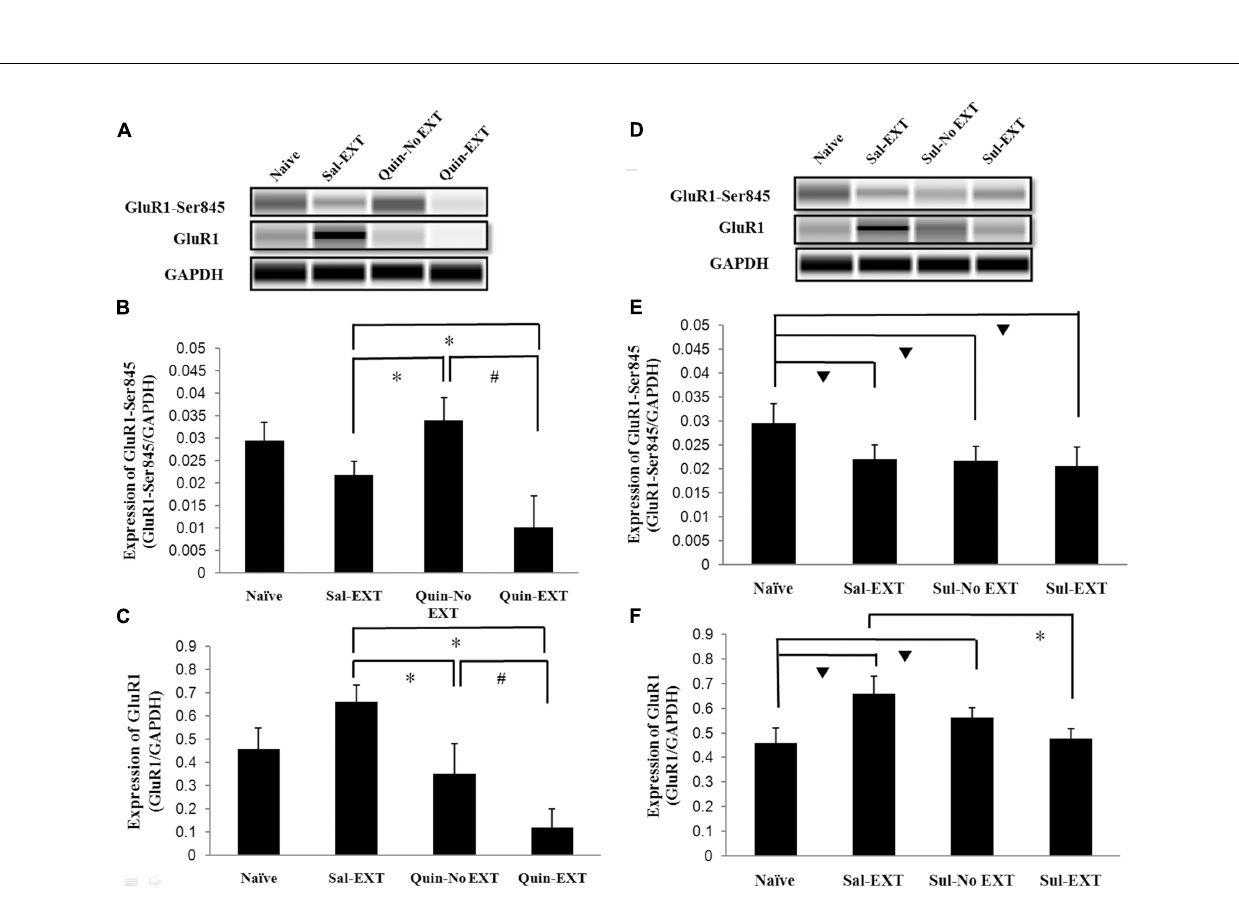
FIGURE 6 | The effects of quinpirole and sulpiride infusion into the BLA before extinction training on GluR1 and GluR1-Ser845 levels after the LTM test. (A–C) Quinpirole rats showed decreased GluR1-Ser845 and GluR1 levels. ∗ P < 0.05 vs. the Sal-EXT group. # P < 0.05 vs. the Quin-No EXT group. (D–F) Sulpiride rats showed decreased GluR1 protein expression but no significant difference in GluR1-Ser845 levels. ∗ P < 0.05 vs. the Sal-EXT group. (cid:72) P < 0.05 vs. the naïve group. n = 3 in each